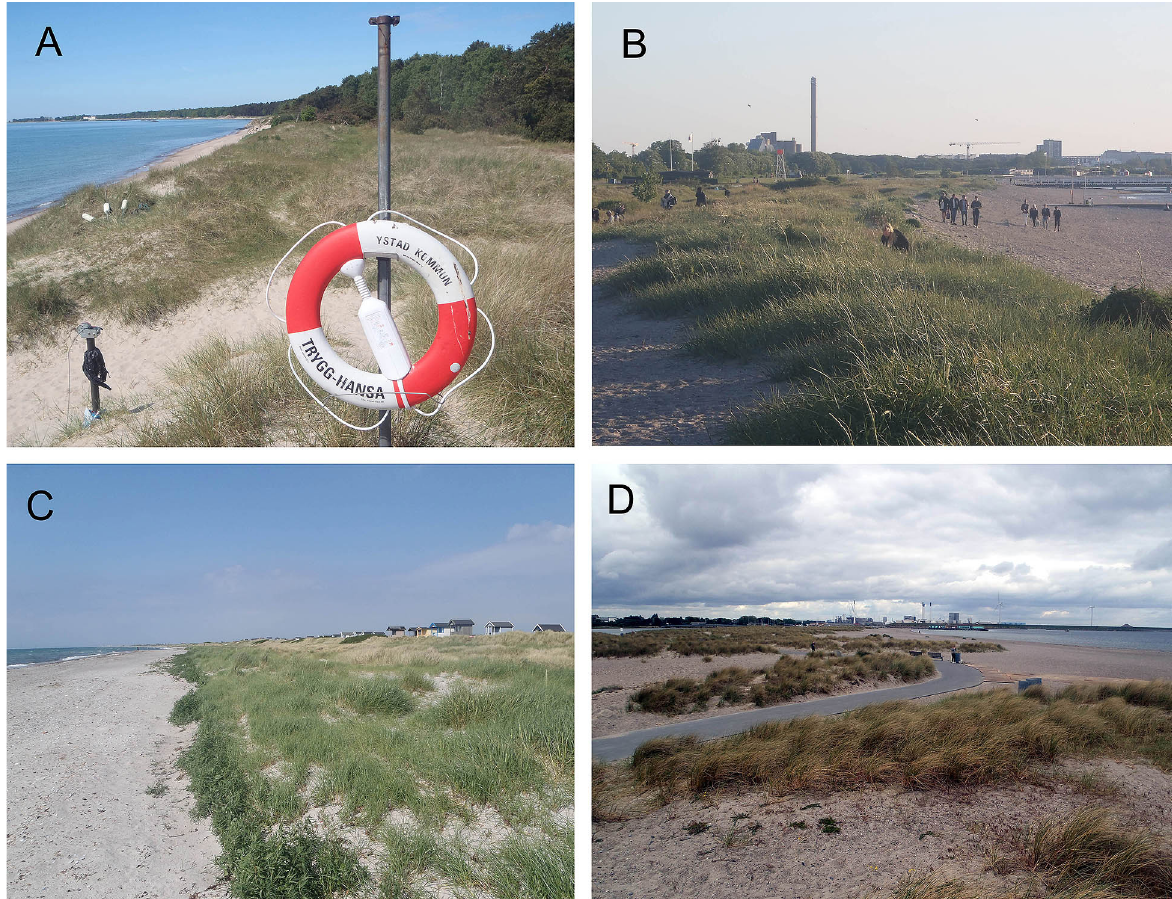
Fig. 2. Low dune ridges in North-west part of Baltic Sea (Photo T. Łabuz